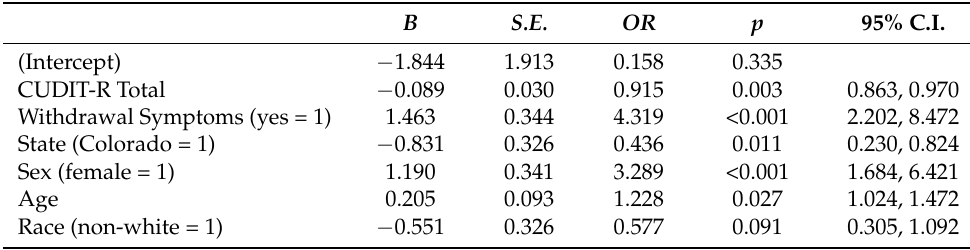
Table 2. Results of logistic regression predicting self-medication with CUDIT-R, sex, state, and withdrawal endorsement, controlling for age and race (N = 281).